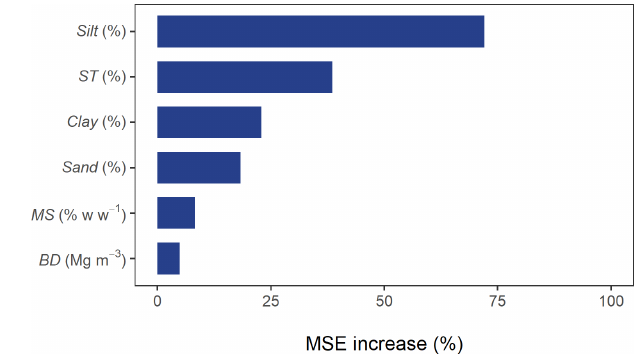
Figure 7. Random forest importance ranking for predicting the dif- ferences in erosion rates between the initial and final time steps of the simulations, for each soil profile. Feature importance is repre- sented by the relative increase of the mean squared error (MSE) of the random forest (i.e. how much removing the feature increased the prediction